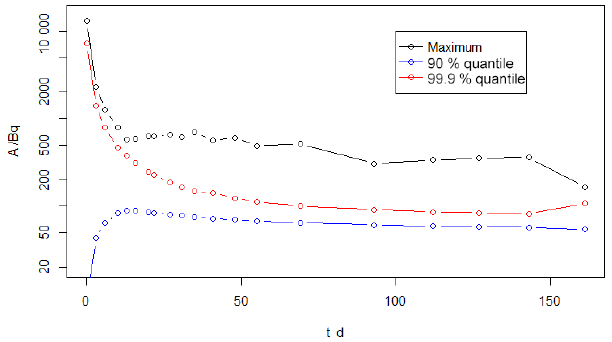
Figure 6. Maximum, 99.9, and 90% quantiles of the amplitude vs. frame time of Fig. 5. The colour scale in Fig. 5 refers to the maxi- mum value.